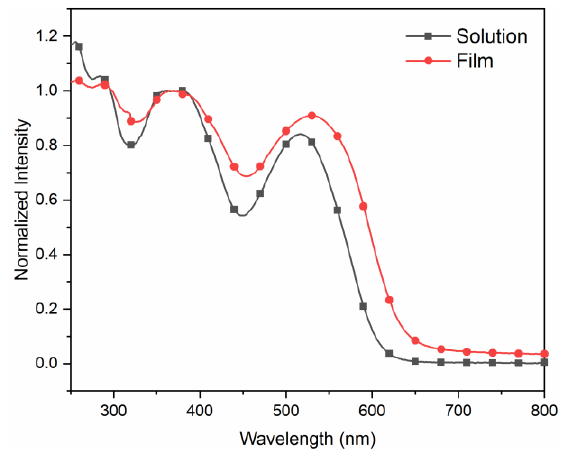
Figure 1. Absorption spectra of polymer in solution (10 − 6 M) film (50 nm).